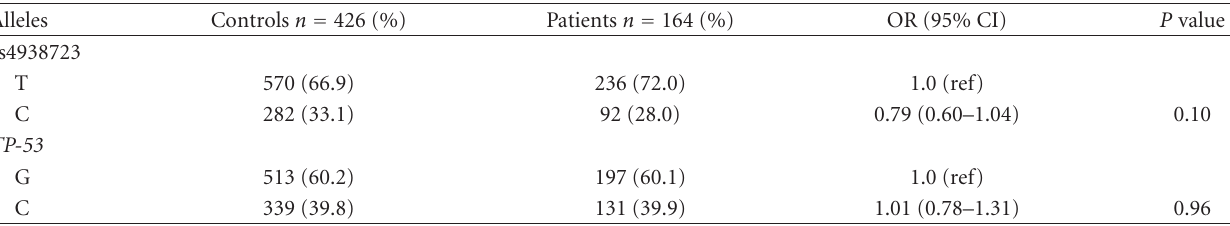
Table 4: Allele frequencies of miR-34 rs4938723 and TP-53 Arg72Pro between patients with intracranial aneurysm and controls.